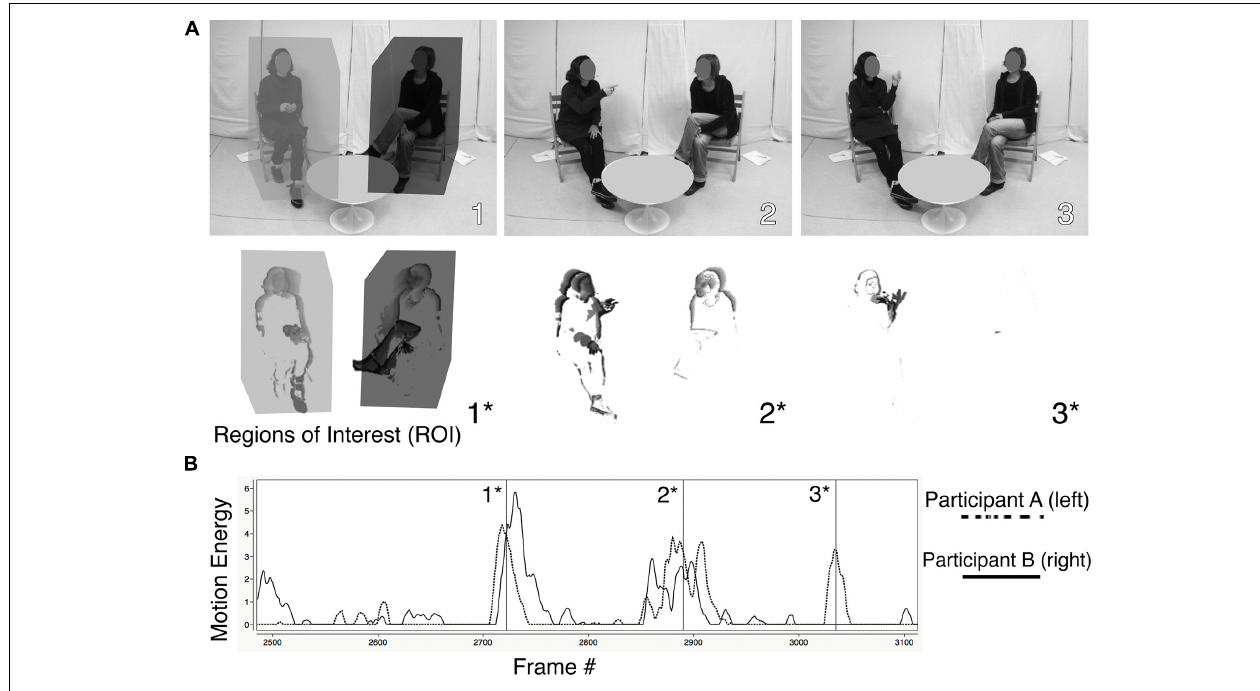
FIGURE 2 | Motion energy analysis (MEA). ( A ; top row), consecutive frames 1, 2, and 3 of split-screen video recordings. ( A ; bottom row), corresponding images of motion energy 1*, 2*, and 3*. (B) time series of individual motion energies (ordinate: smoothed, z -standardized